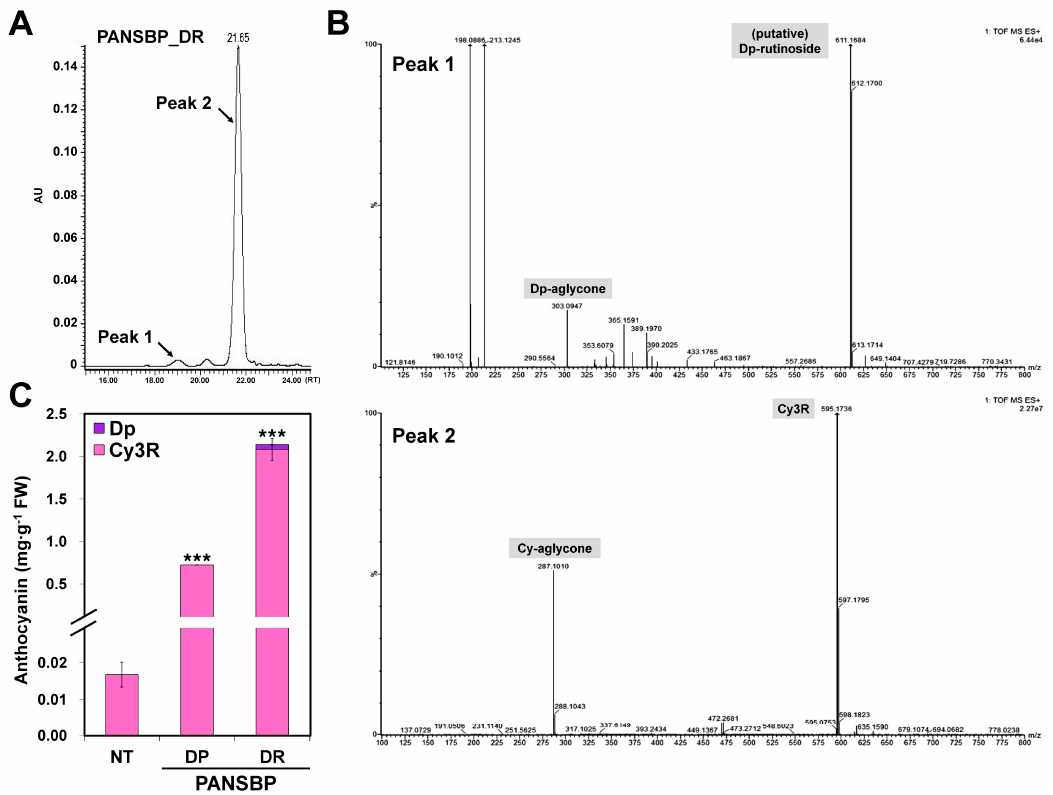
Figure 6. Analysis of anthocyanin levels in the petals of non-transformed (NT) and PANSBP transgenic lines. ( A ) UPLC chromatogram of anthocyanins extracted from the petals of PANSBP_DR line; ( B ) TOF (quadrupole time of flight) mass spectra of the peak 1 and peak 2; ( C ) Anthocyanin levels in NT and transgenic lines (Dp, delphinidin derivative; Cy3R, cyanidin-3- O -rutinoside). The result of ( C ) represents mean values ± SD from three biological replicates. *** Indicate values that differ significantly from NT at p < 0.001 according to a Student’s paired t -test.